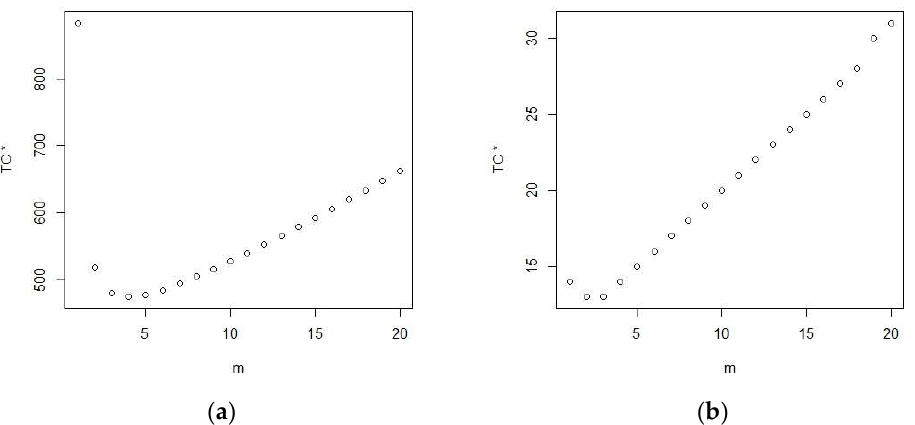
Figure 2. ( a ): Total cost curve at m = 1: m 0 for the first case; ( b ) total cost curve at m = 1: m 0. for the second case.